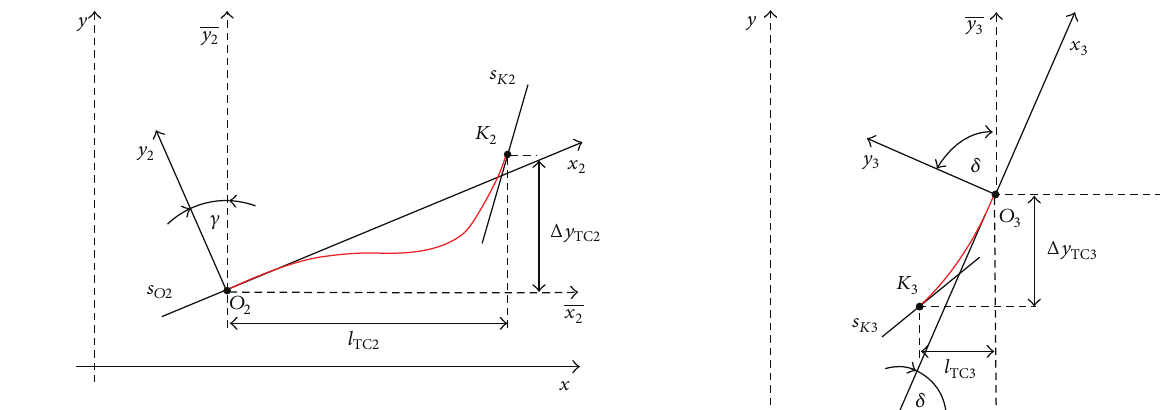
Figure 3: Diagram presenting the position of transition curve TC2.